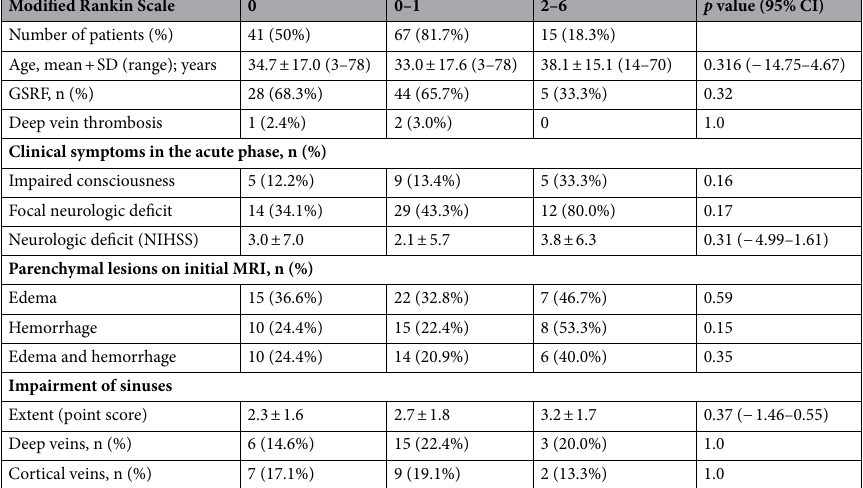
Table 1. Baseline characteristics of the groups according to the clinical outcome. Values are expressed as n (%) or mean ± standard deviation. Fisher’s exact test was used for calculation of p values of categorical data and unpaired two-tailed t-test was used for calculation of p values of continuous data. CI 95% confidence interval of the difference of the mean of group “0–1” minus group “2–6”, GSRF gender-specific risk factors, MRI magnetic resonance imaging, NIHSS National Institutes of Health Stroke Scale, SD standard deviation.